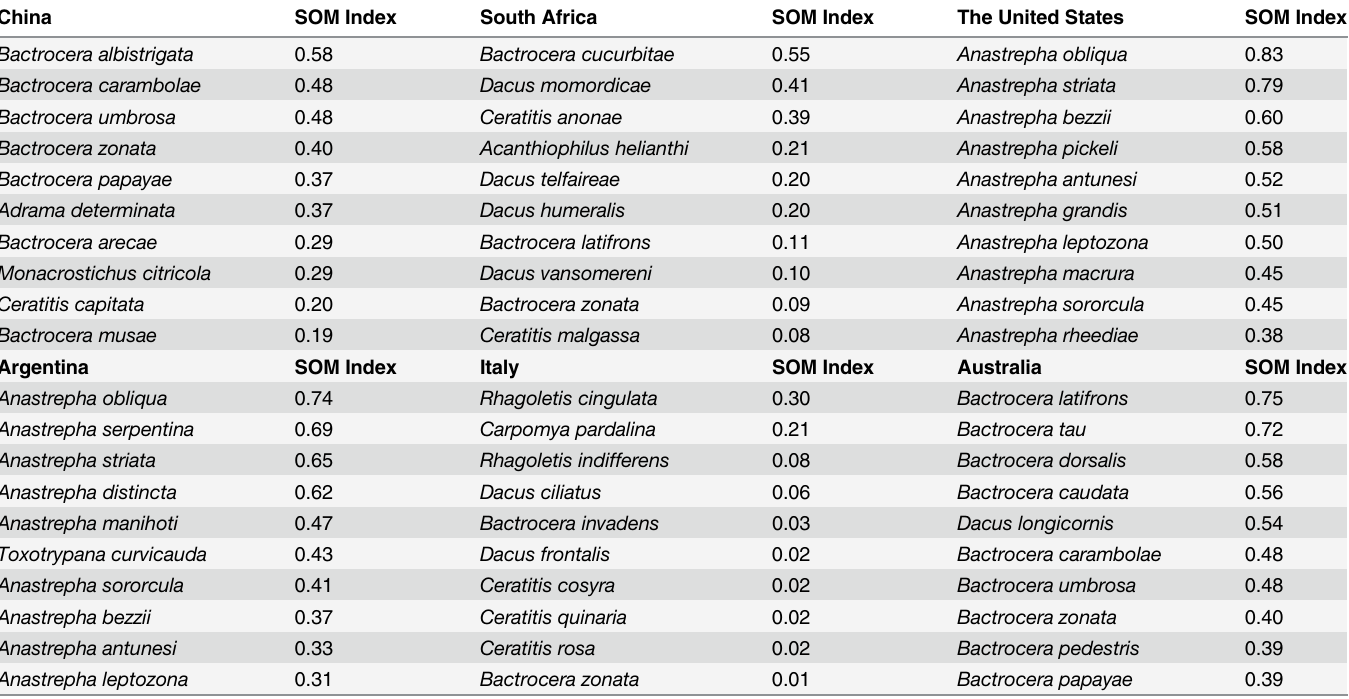
Table 2. Top ten ranked fruit fl y species by establishment index for six countries. Only those species currently absent from a country and a known pest of a host commercially grown in that country were included (for full list see S1 Table).